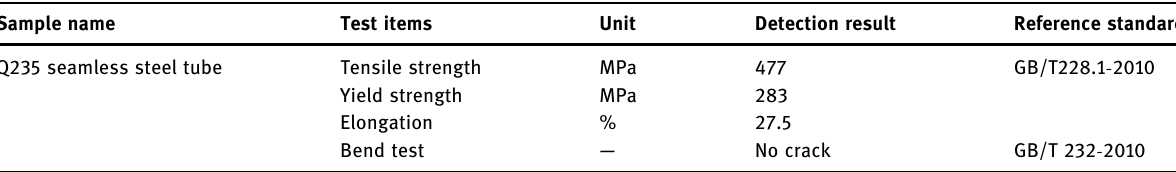
Table 7: Steel inspection